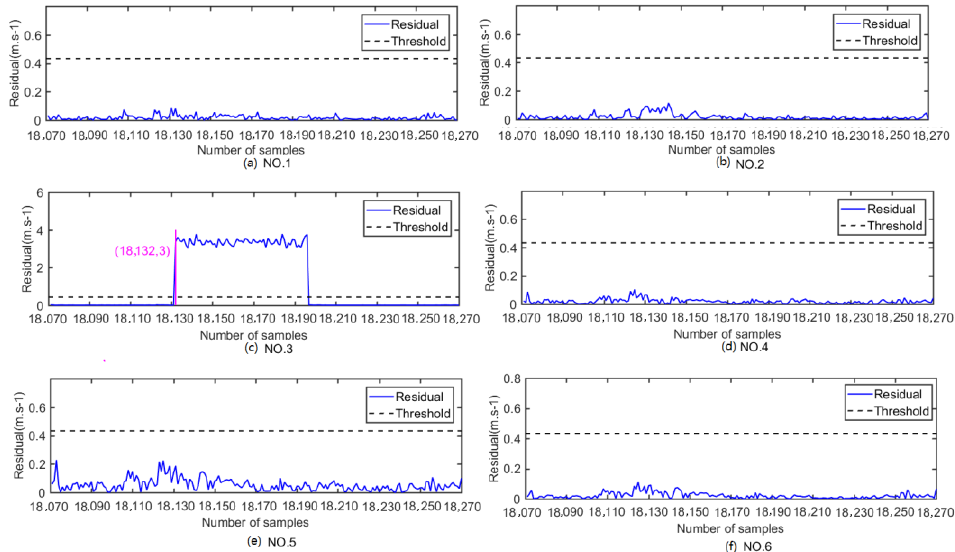
Figure 11. Fixed deviation fault of anemometers for six wind turbines in 2016. ( a ) Residual curve of WTG 1; ( b ) Residual curve of WTG 2 ( c ) Residual curve of WTG 3 ( d ) Residual curve of WTG 4 ( e ) Residual curve of WTG 5 ( f ) Residual curve of WTG 6.